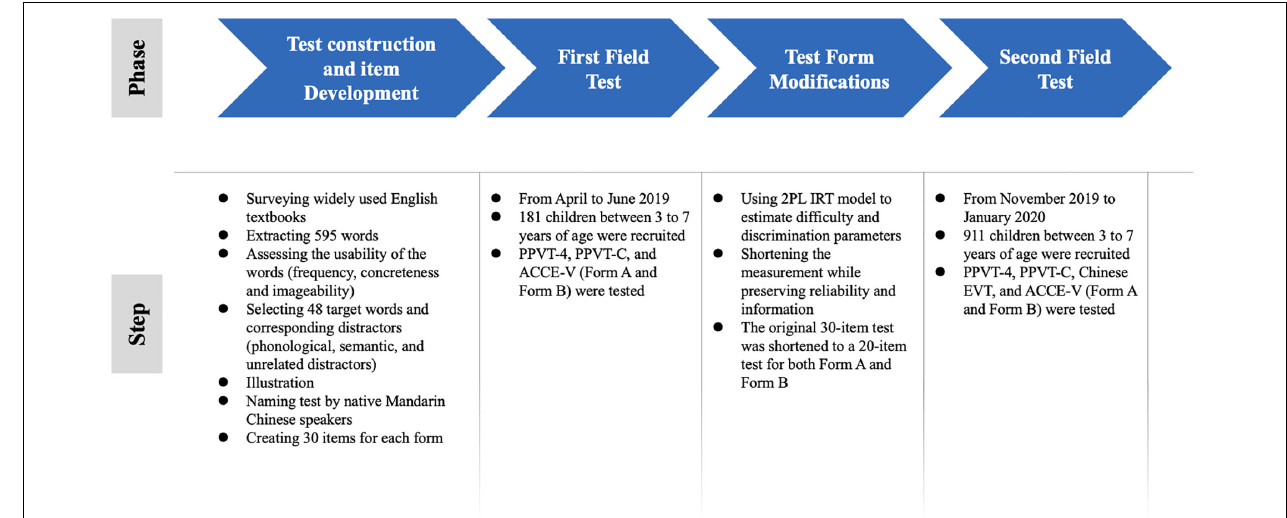
FIGURE 1 | Procedure of the ACCE-V